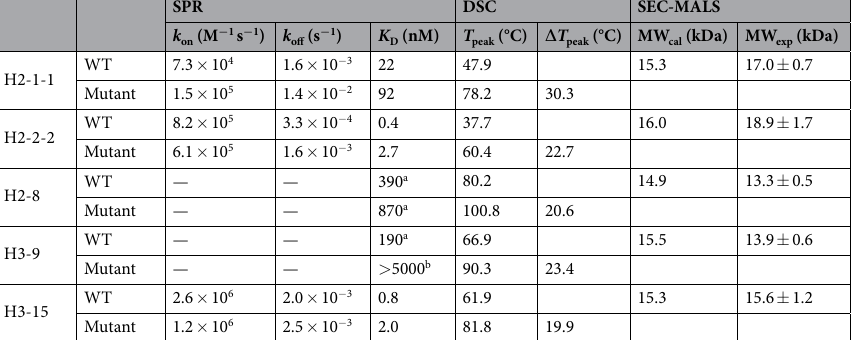
Table 1. Characterizations of antigen specific rVHs. MW cal : Molecular weight (MW) calculated from amino acid composition. MW exp : Experimentally obtained MW. a For H2-8 and H3-9, K D values were determined by steady–state affinity analysis. b K D value for the C54-C78 mutant of H3-9 could not be determined up to 5 µ